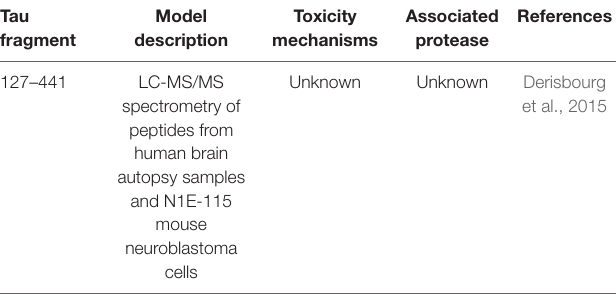
TABLE 3 | Tau fragments with unknown pathogenic